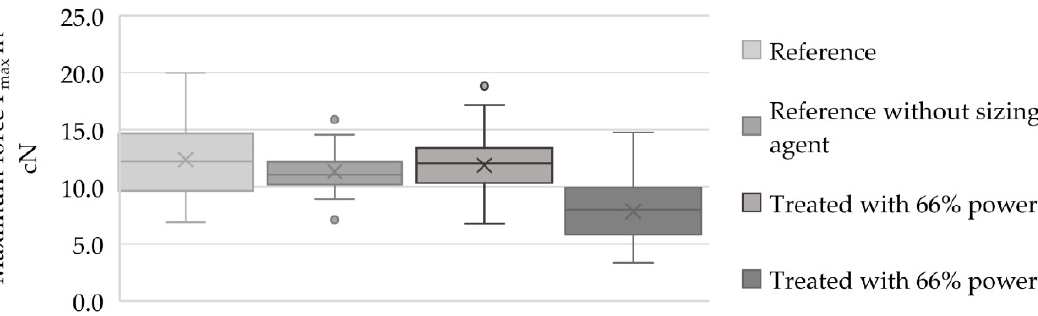
Figure 8. Boxplot diagram with maximum force results (F max in cN) of the filament references and the treated and detached filaments.